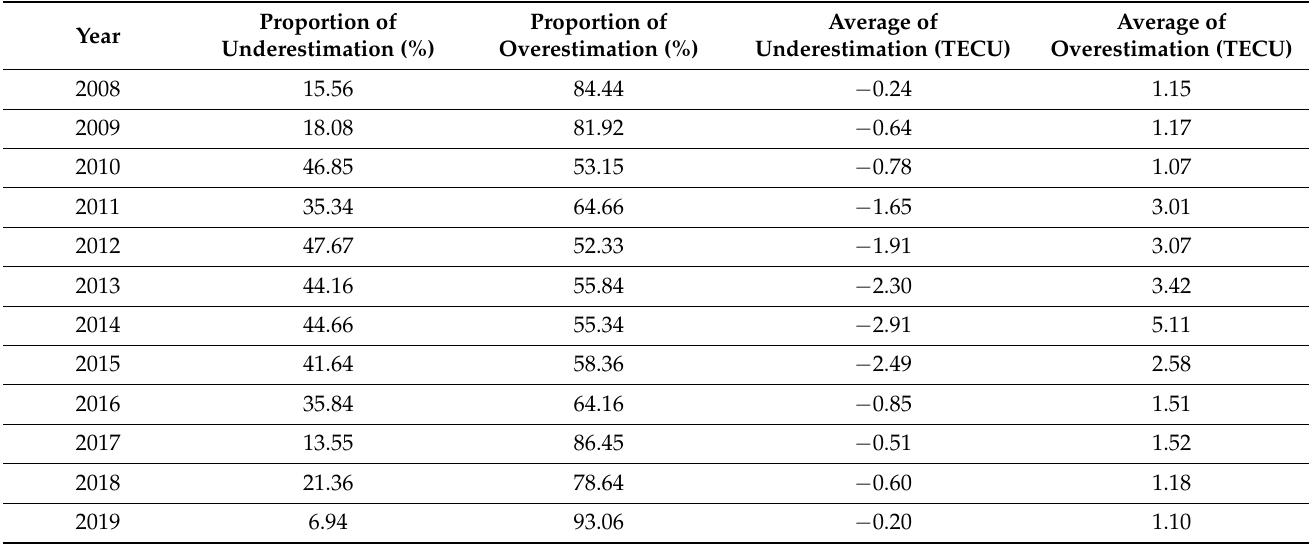
Table 2. Bias Statistical characters of NeQuick2 with respect to Jason2 from 2008 to 2019. Proportion of Proportion of Average of Average of Year Underestimation (%) Overestimation (%) Underestimation (TECU) Overestimation